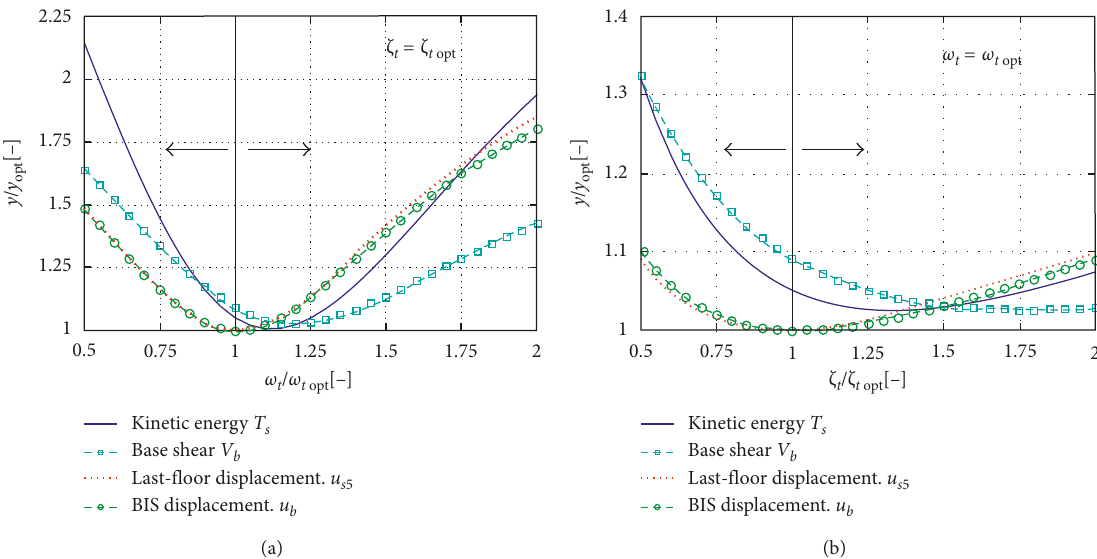
Figure 20: Impact of tuning failure due to imperfect knowledge of the structural TMD dynamic parameters: effect on four response